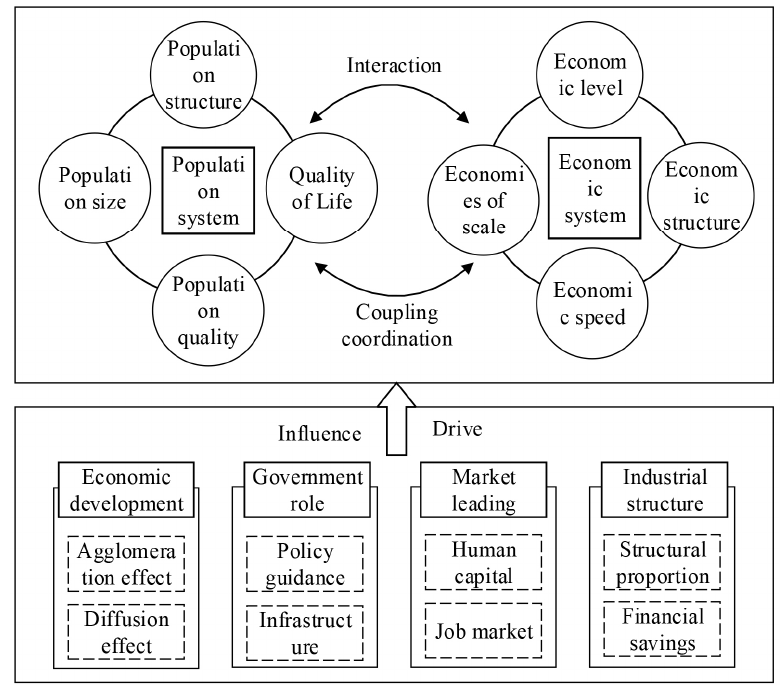
Figure 2. Driving mechanism of population and economy coupling coordination degree.